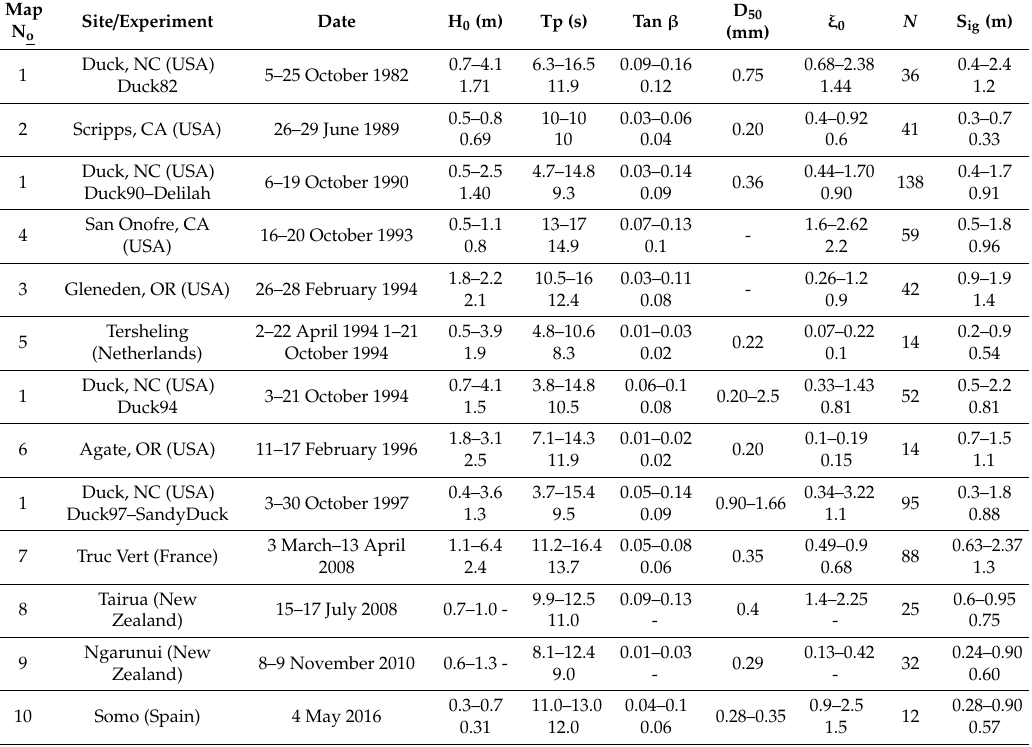
Table 1. Summary (range and mean) of environmental parameters and significant infragravity swash height (S ig ) sampled during previous research .1 . Subscript 0 indicates parameters calculated using deep water values, linearly deshoaled to 80 m water depth. N = number of observations; NC = North Carolina; CA = California; OR = Oregon; USA = United States of